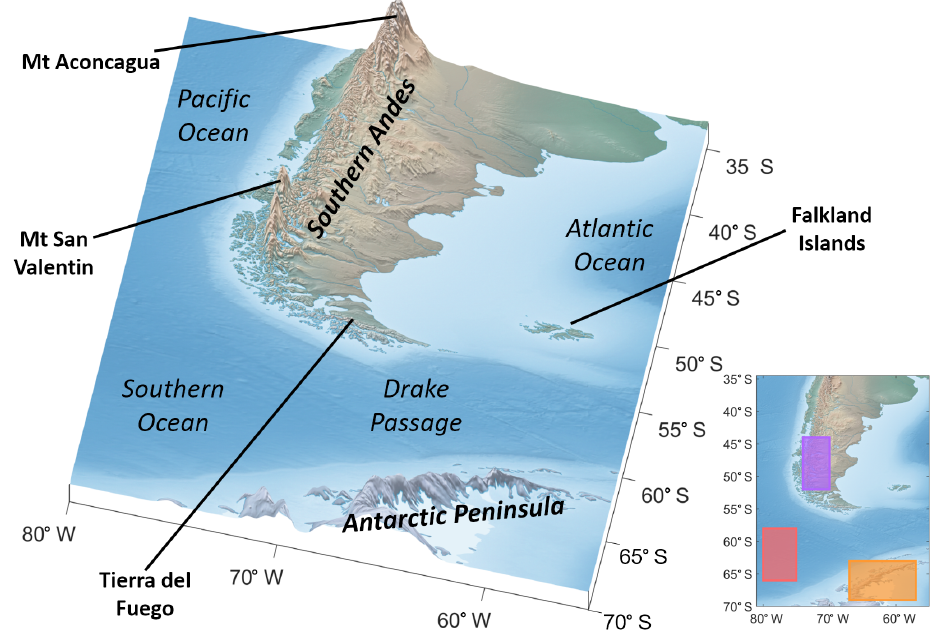
Figure 1. Map of region examined in this study, defining geographic terms used. Inset shows subregions examined in Sect. 6: “Andes” (purple), “Peninsula” (orange), and “Southern Ocean”